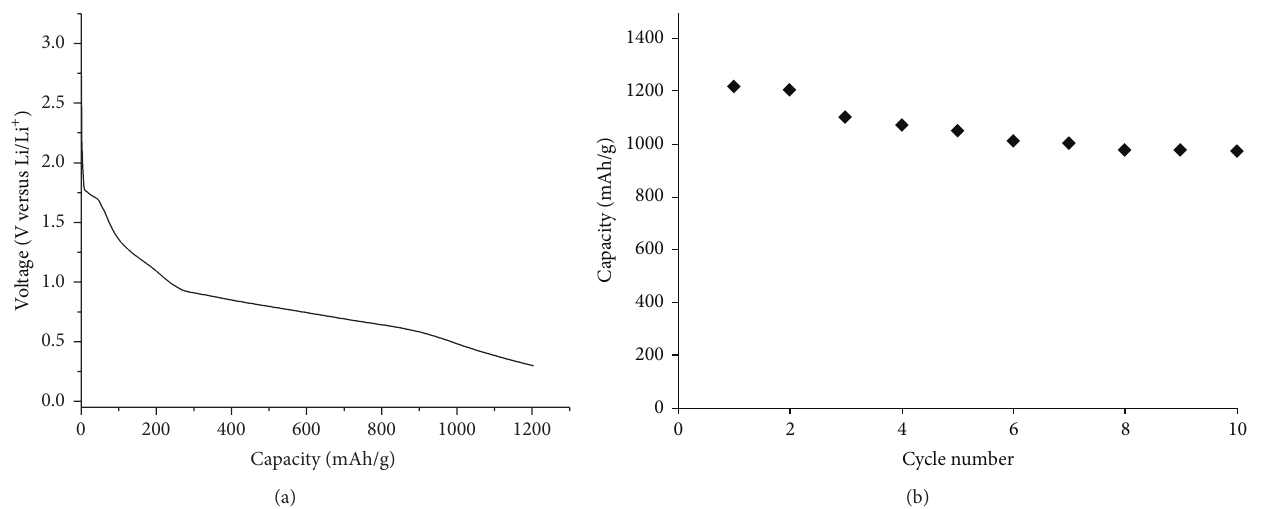
Figure 8: (a) First discharge of SnO 2 -CNT composite. (b) Electrochemical properties of SnO 2 -CNT composite during the first 10 cycles. 1200 mAh/g and a charge capacity of 200 mAh/g. This